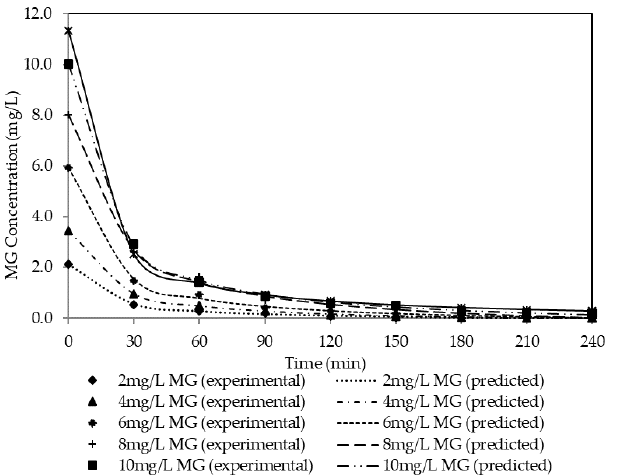
Figure 14. Mechanism of the MG extraction.